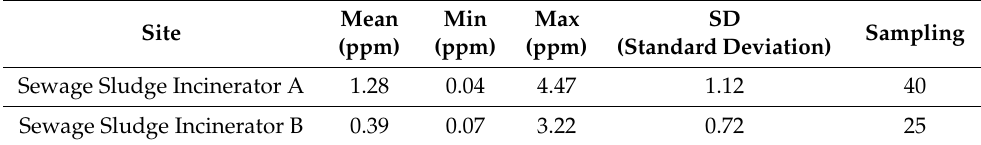
Table 2. NH 3 concentration of the investigated sewage sludge incinerators.